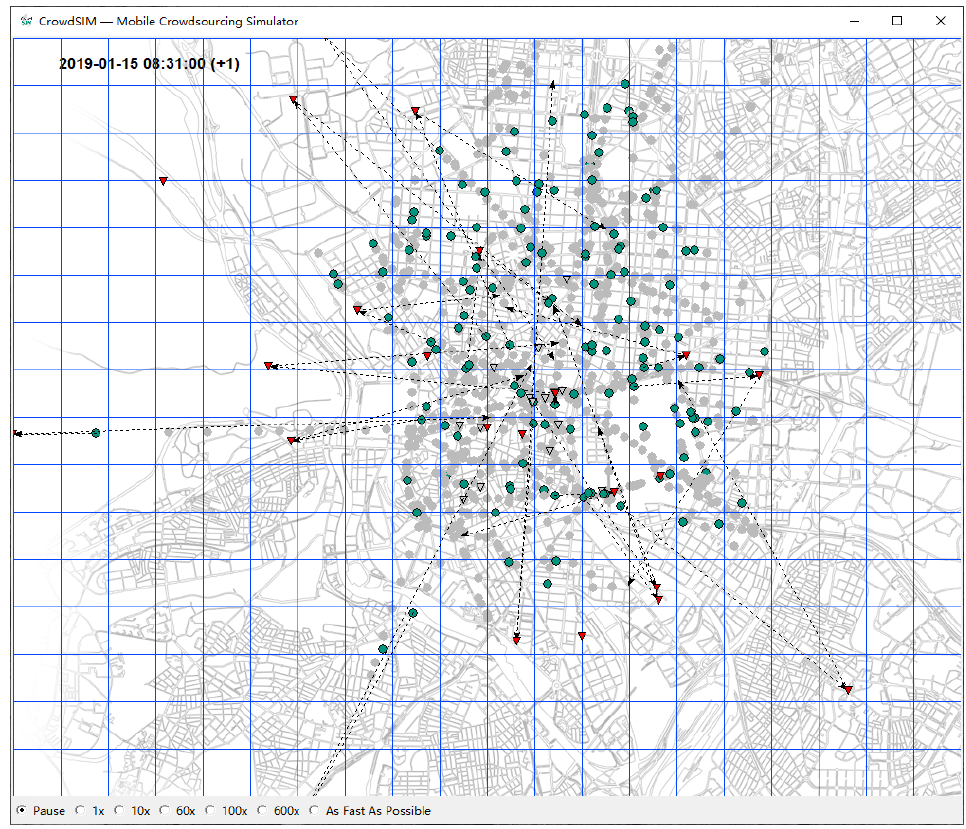
Figure 2. Agent-based simulator at